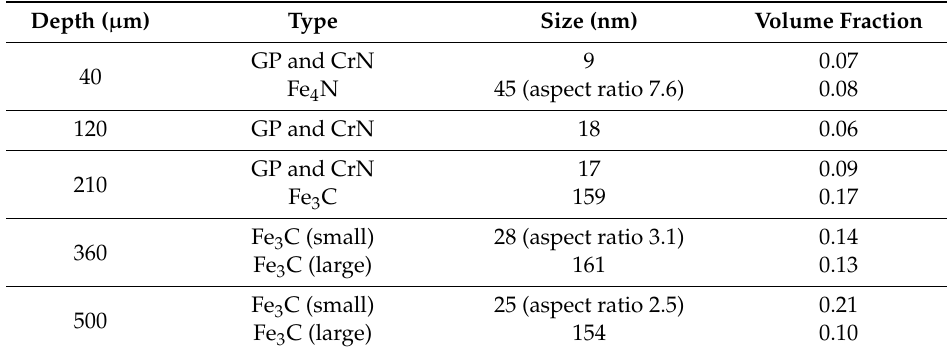
Figure 8. TEM images of the nitrided steel ( a ) at the depth of 360 µm and ( b ) in the center matrix with the SAED inserted. The blue circle shows the large globular Fe 3 C, and the red circle marks the small rod-like one. Table 2 summarized the types, sizes and volume fractions of all particles determined by TEM along the depth of nitrided sample. Table 2. Type, size and volume fraction of precipitates at di ff erent